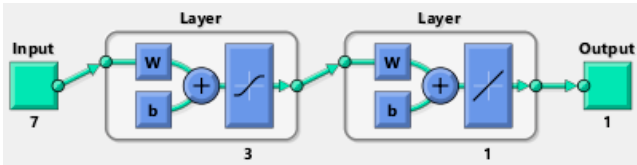
Figure 23. General structure of the ANN we apply.